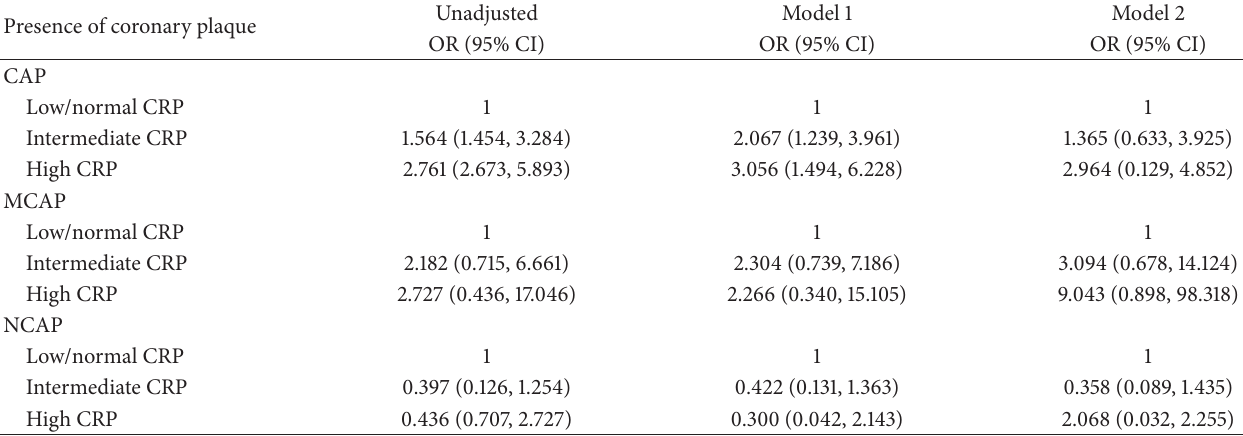
Table 3: Multivariate logistical regression analysis of coronary plaque subtype and CRP